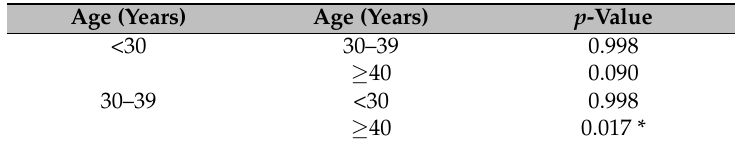
Table 7. Post hoc tests for age